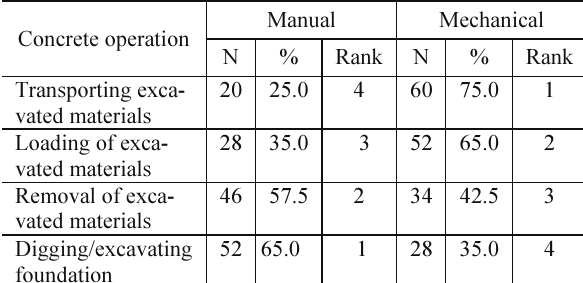
Table 3. Ranking of the levels of mechanisation of tasks in excavation operation